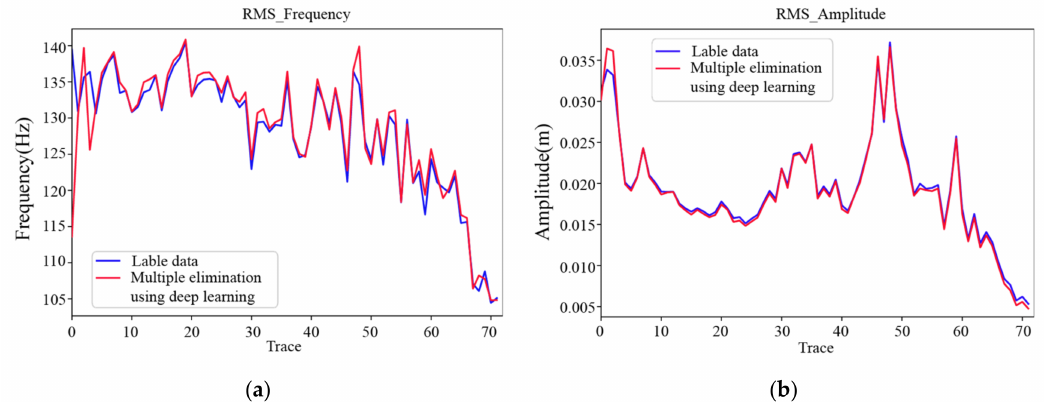
Figure 19. Attribute analysis with multiple elimination using deep learning. ( a ) Root mean square frequency analysis of seismic data with multiple elimination using deep learning in Figure 18b,d. ( b ) Root mean square amplitude analysis of seismic data with multiple elimination using deep learning in Figure